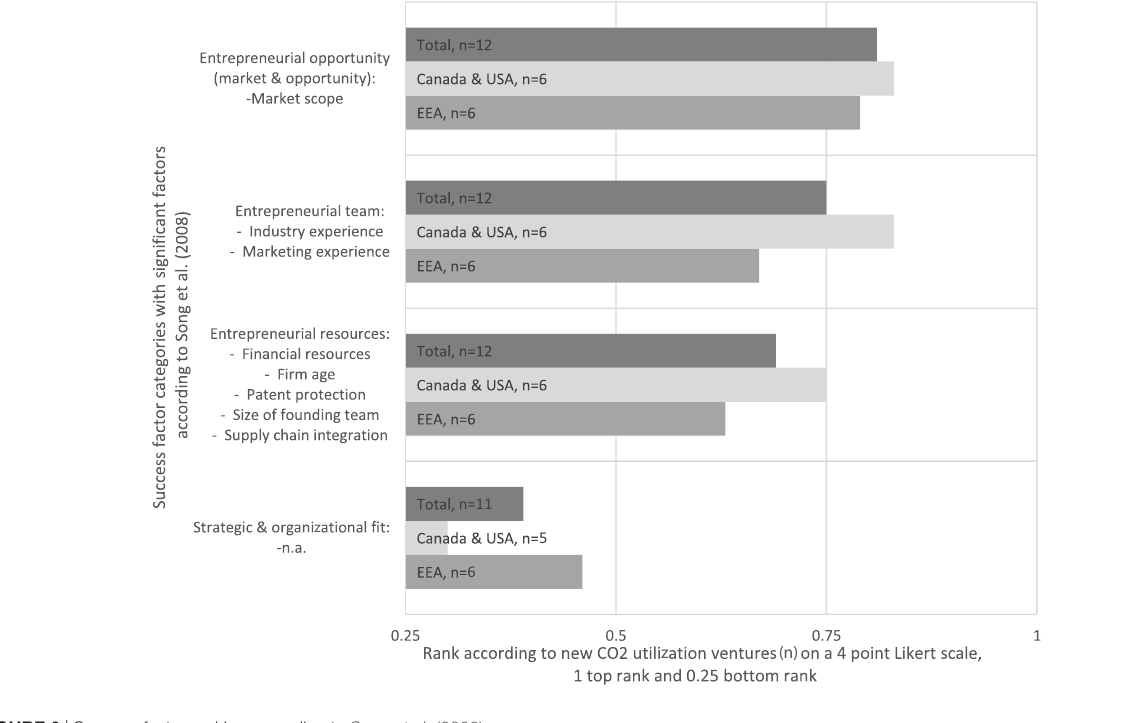
FigUre 6 | Success factor ranking according to Song et al. (2008).